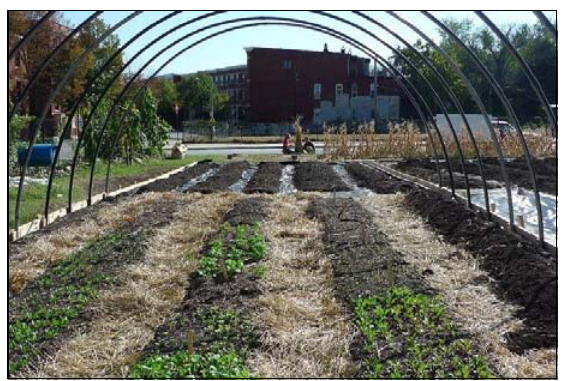
Figure A. Whitelock Community Farm was established in 2010 with the goal of providing fresh produce for residents in Baltimore’s Reservoir Hill neighborhood. Photograph courtesy of Whitelock Community Farm.